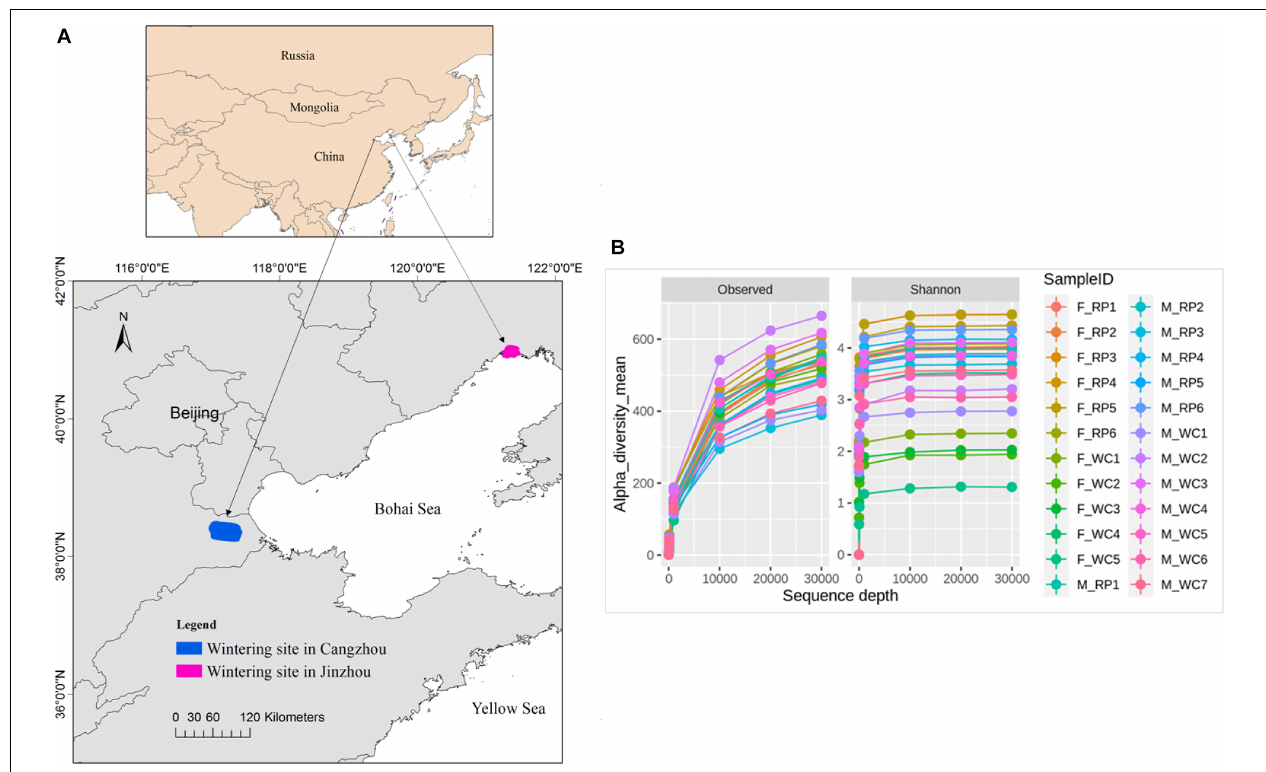
FIGURE 1 | (A) Fecal sampling sites of Asian Great Bustard in wintering site in Cangzhou (blue), Hebei province and Jinzhou (red), Liaoning province. (B) The sequencing depth and rarefaction curve for each sampling individual. F_RP: females with Rice_Peanut diet, M_RP: males with Rice_Peanut diet, F_WC: females with Wheat_Corn diet and M_WC: males with Wheat_Corn